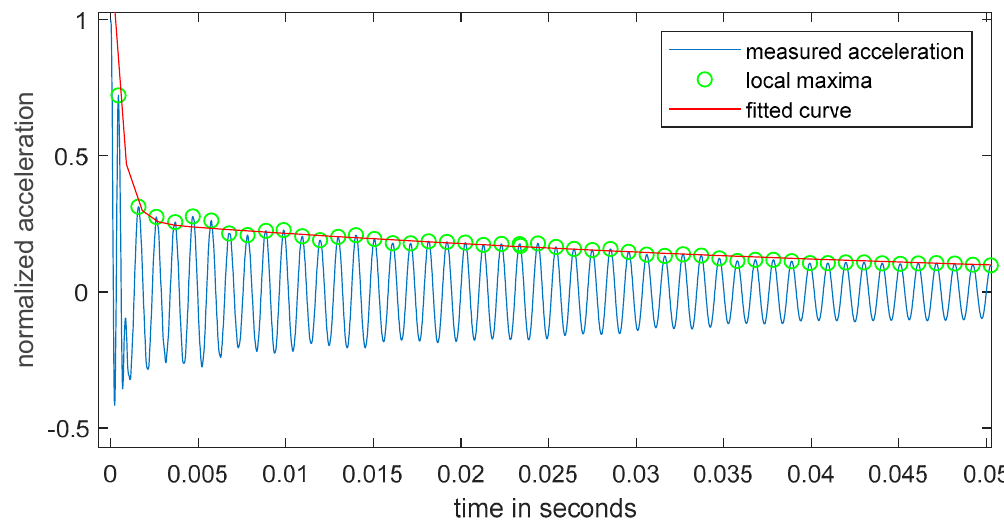
Figure 7. Measured acceleration with marked highpoints and calculated fitting curve.